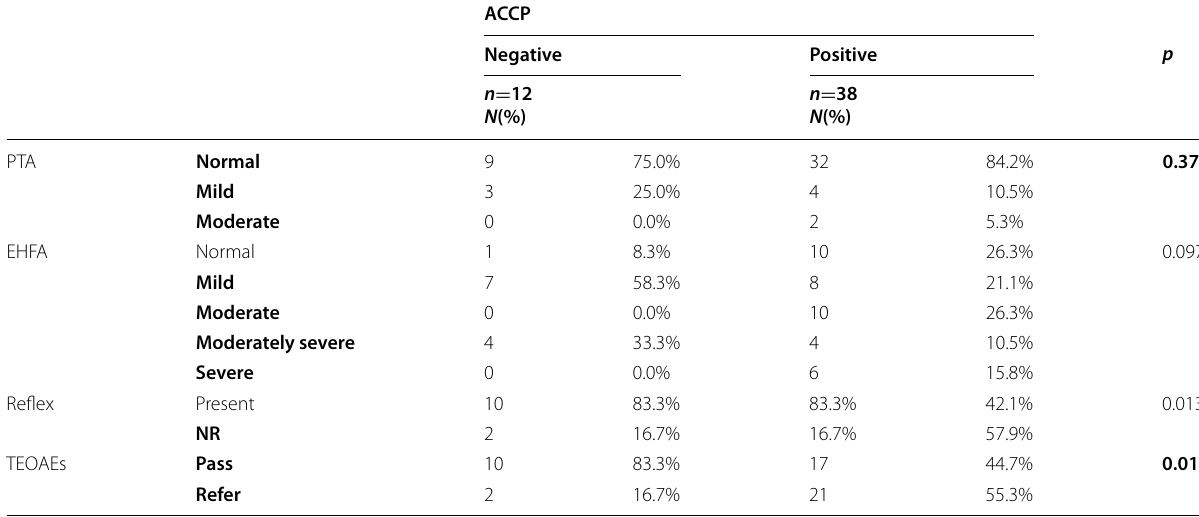
Table 3 Correlation between audiological parameters and ACCP